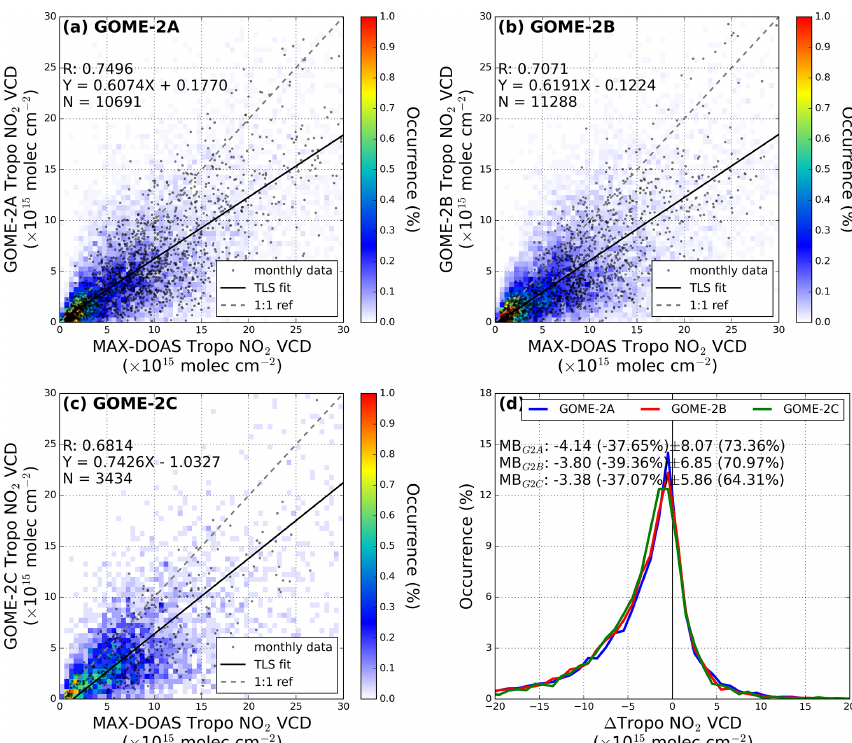
Figure 17. Comparison of daily and monthly tropospheric column NO 2 measured by the ground-based MAX-DOAS to (a) GOME-2A, (b) GOME-2B, and (c) GOME-2C. Histograms of the difference in tropospheric column NO 2 between GOME-2 and MAX-DOAS are shown in panel (d) . Co-located daily and monthly averaged data are used in the comparison. Total least-squares regression is based on daily data.